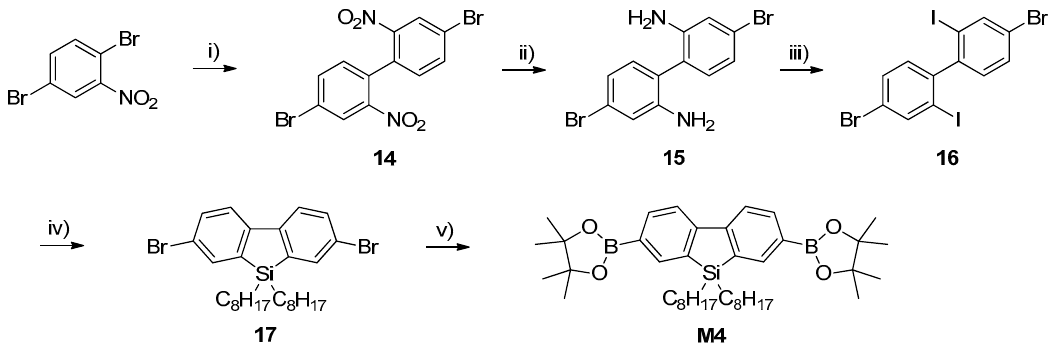
Scheme 2. Synthetic steps of the monomer 9,9-dioctyl-2,7-bis(4,4,5,5-tetramethyl-1,3,2-dioxaborolan- 2-yl)-dibenzosilole